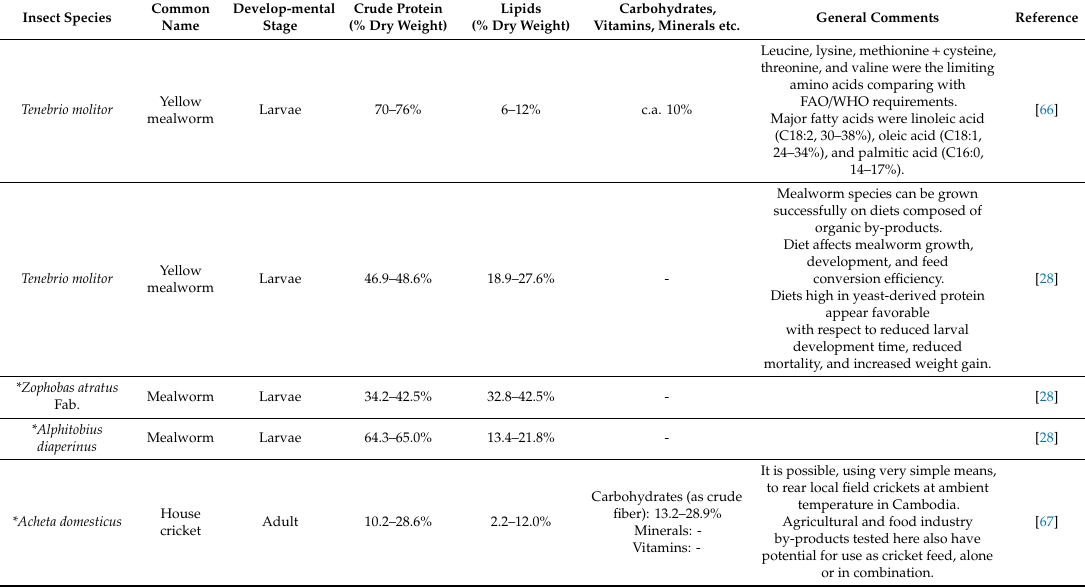
Itispossible,usingverysimplemeans, torearlocalfieldcricketsatambient temperatureinCambodia. Agriculturalandfoodindustry by-productstestedherealsohave Vitamins: - potentialforuseascricketfeed,alone